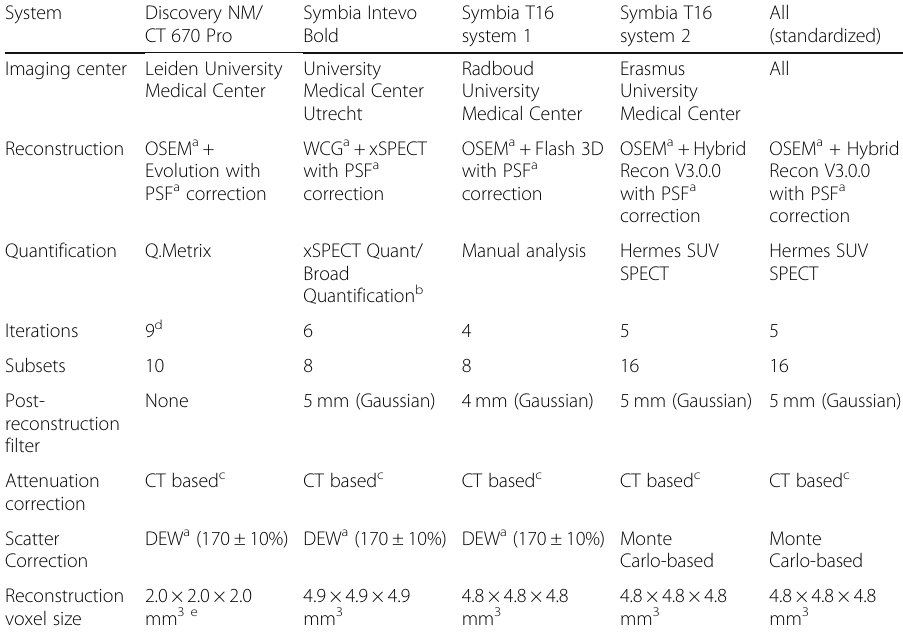
Table 2 Reconstruction/quantification parameters and processing software used in this study. Quantification packages Q. Metrix, xSPECT Quant, and Broad quantification enable quantitative reconstructions in the scanner